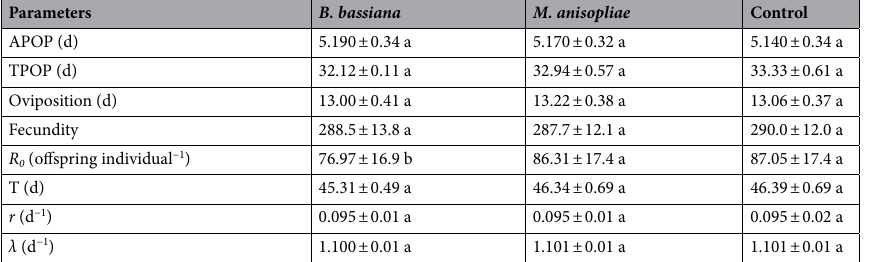
Table 2. Comparison of reproductive and life table parameters (mean ± SE) of Coccinella septumpunctata after exposure of entomopathogenic fungi. SE was estimated by bootstrapping (100,000). Whereas APOP, TPOP, T, r, λ, and Ro represents an adult pre-oviposition period (days), total pre-oviposition period (days), mean generation time (days), intrinsic rate of increase (d −1 ), and finite rate of increase (d −1 ), net reproductive rate (offspring) respectively, means sharing similar letters in each row are not significantly different at P > 0.05.